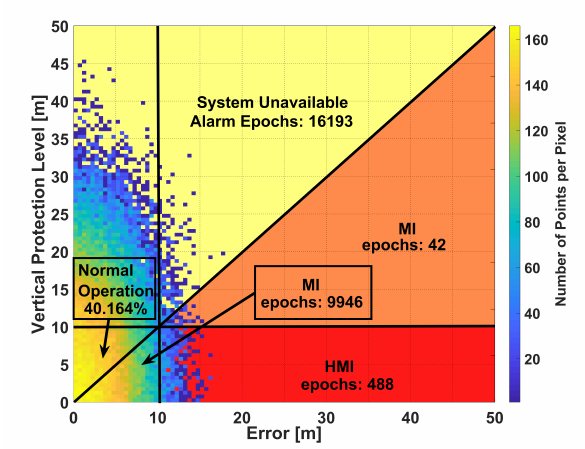
Figure 2. Example of Stanford diagram indicating the